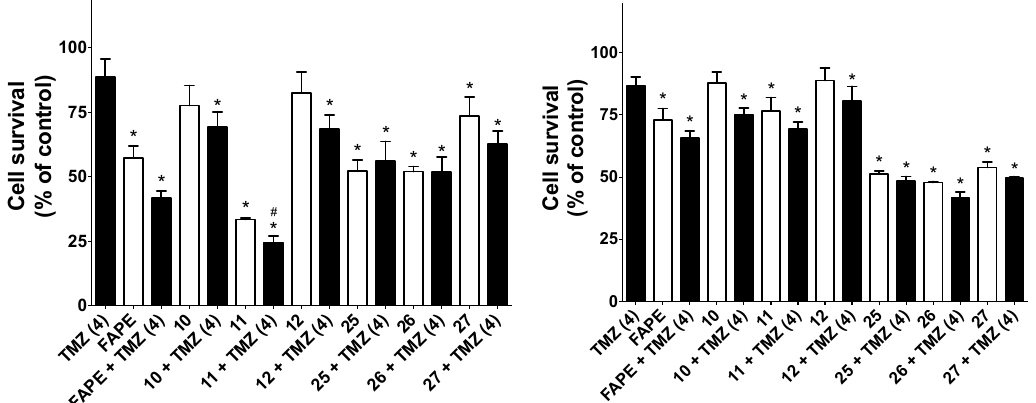
Figure 8. Hs683 ( left panel ) and LN319 ( right panel ) cell viability following treatment with FAPE ( 1b ) analogs alone or in combination with TMZ as described in the Methods. Values are the means ± SEM of three independent experiments, each performed in quadruplicate. * different from control (diluent) as determined by one way ANOVA with Dunnett’s multiple comparison test ( p < 0.05). # different from treatment with compound in absence of TMZ as determined by two-sided t -test ( p < 0.05).